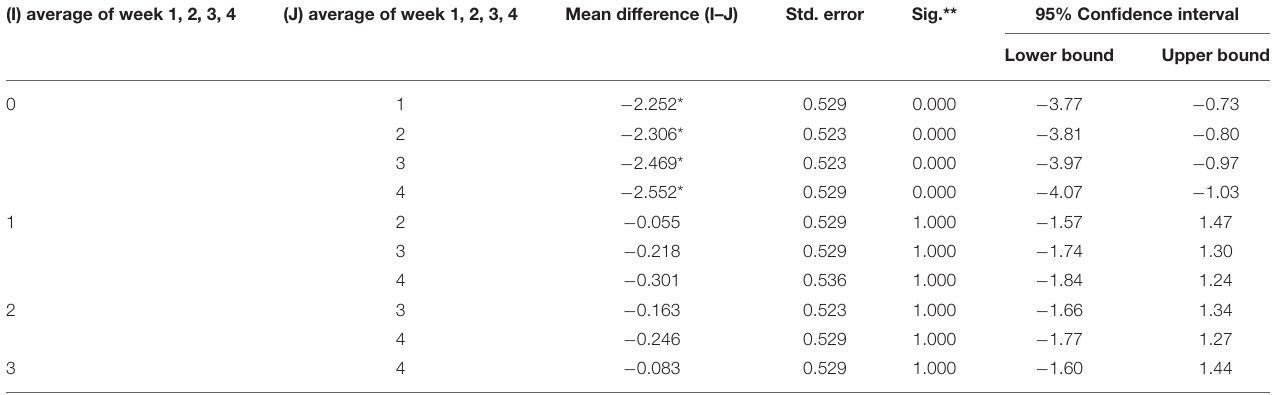
TABLE 6 | Comparisons of mean number of sessions of eye activities done during pre-intervention and at week 1, 2, 3, 4 after intervention. (I) average of week 1, 2, 3,